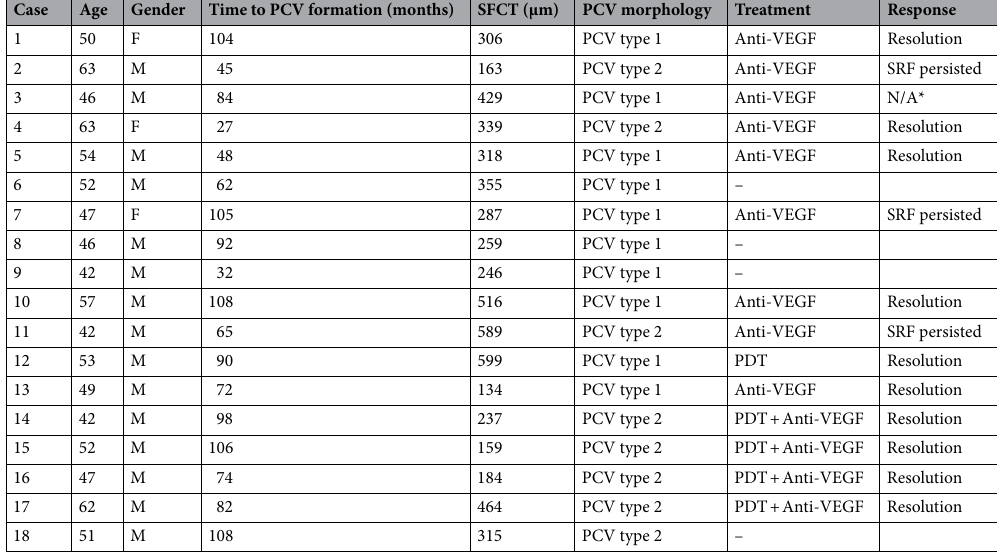
Table 3. Clinical Features of PCV Subsequent to Chronic CSC. *Lost of follow-up; F, female; M, male; SFCT, subfoveal choroidal thickness; SRF, subretinal fluid; PDT: photodynamic therapy; VEGF, vascular endothelial growth factor; PCV, polypoidal choroidal